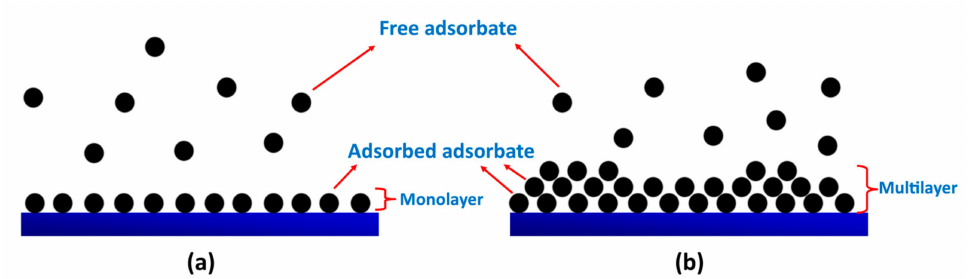
Figure 6. Schematic representation of monolayer and multilayer adsorption of heavy metals. ( a ) monolayer adsorption, ( b ) multilayer